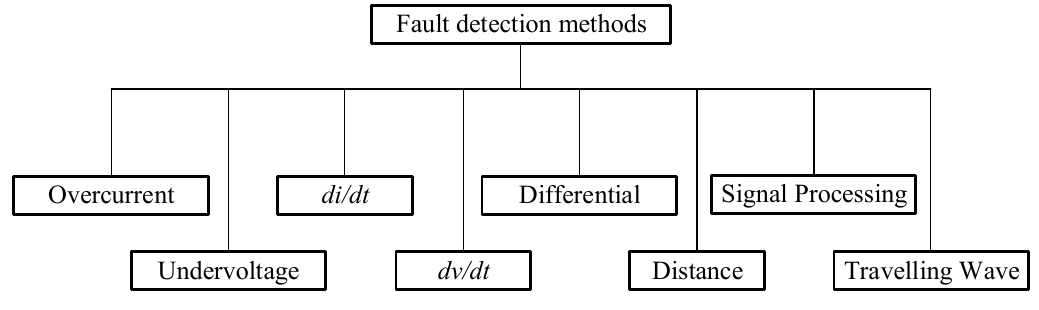
Figure 1. Fault detection